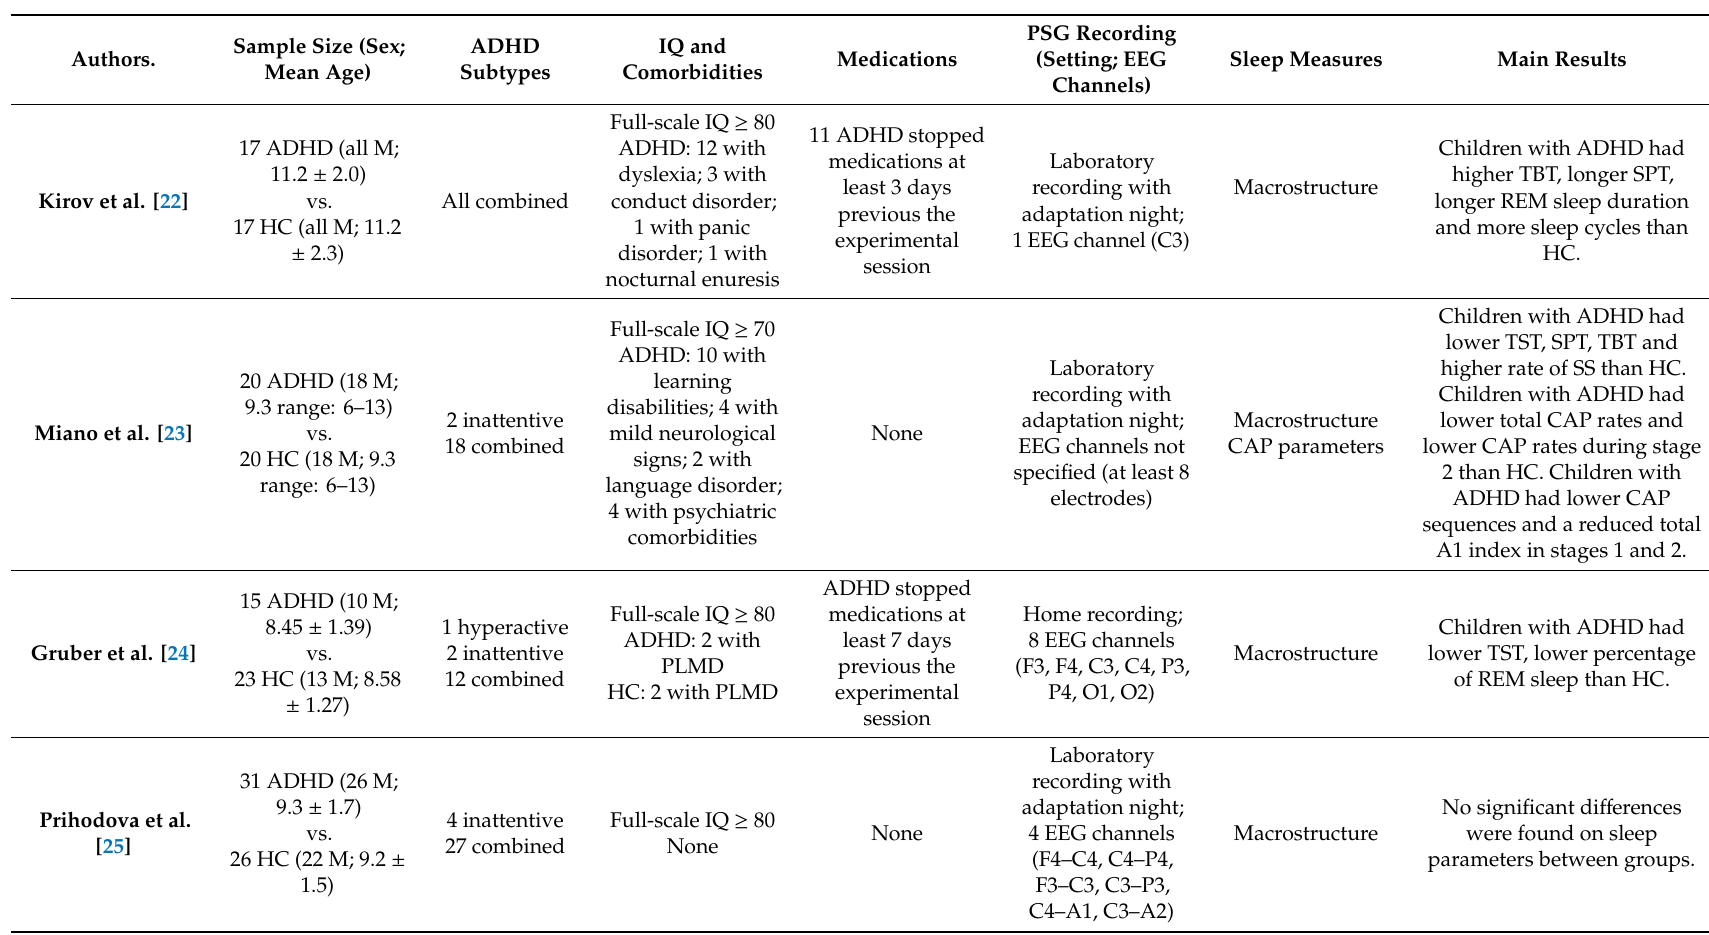
Table 1. Summary of characteristics of included